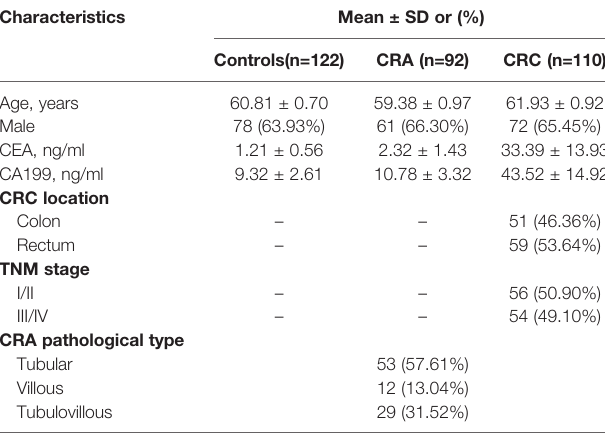
TABLE 1 | Demographic and clinical characteristics of CRA patients, CRC patients, and the healthy individuals.